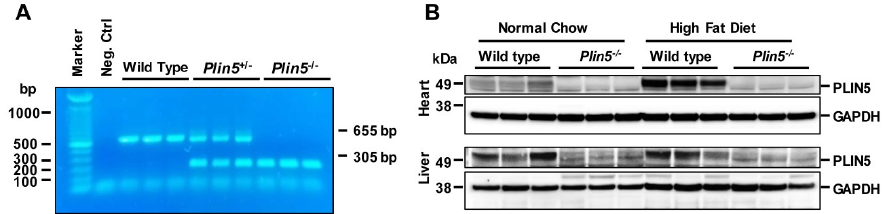
Figure 1. Generating of Plin5 − / − mice. ( A ) Confirmation of Plin5 gene disruption by conventional PCR with genomic DNA prepared from mouse ear tips. Bands at 655 bp indicate wild type and 305 bp Plin5 knockout alleles, while the presence of both bands indicates heterozygous mice. Neg. Ctrl = no template control. ( B ) Protein levels of PLIN5 revealed by Western blot analysis in hearts and livers of mice after 30 weeks on normal chow or high-fat diet. GAPDH served as a loading control. WT and Plin5 − / − C57BL/6J mice were fed an HFD for 30 weeks (40% fat, 20% fructose and 2% cholesterol), while control mice received a NC (9% fat, 58% carbohydrates, 33% protein). All animals